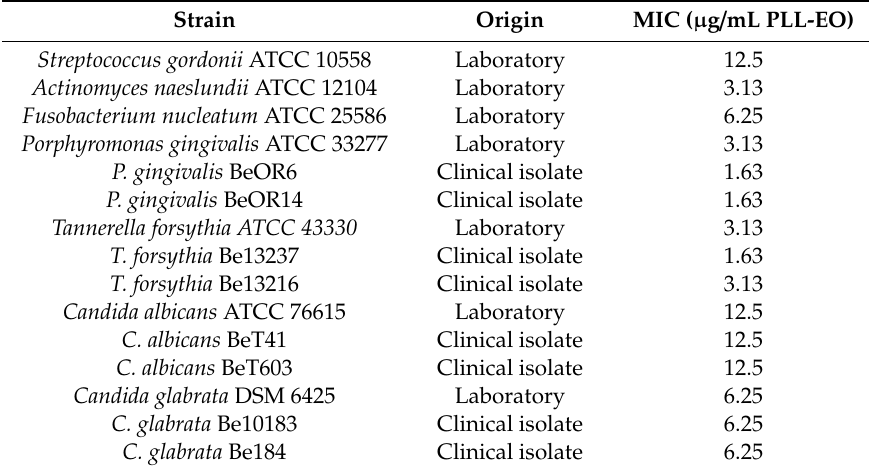
Table 2. MIC ( µ g / mL) of Pistacia lenticus L. essential oil against oral